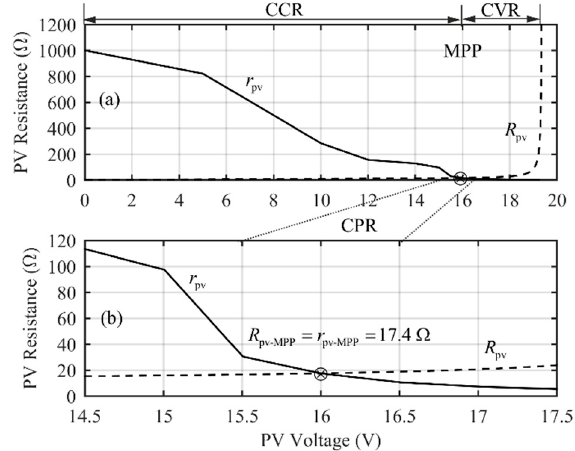
Figure 2. Authentic behavior of the dynamic and static resistances of Figure 1: ( a ) when the PV voltage varies from zero to maximum voltage, ( b ) when the photovoltaic (PV) voltage varies in the vicinity of maximum-power-point (MPP) including CPR.